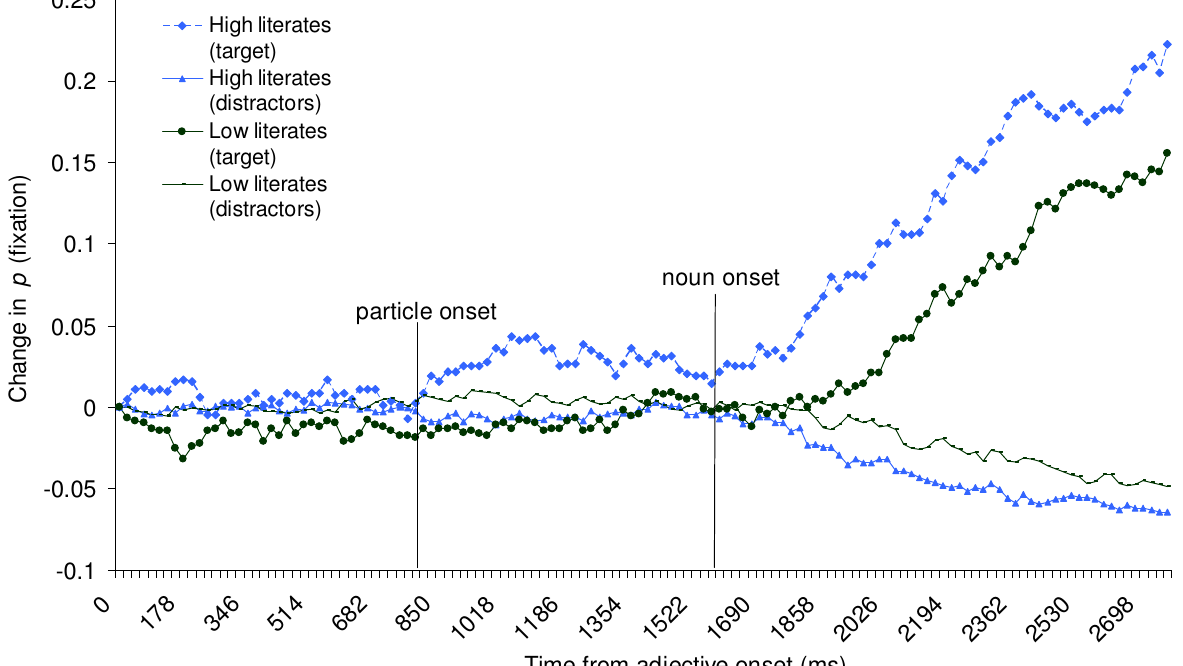
Figure 2 . Changes in fixation proportions on the target objects and (averaged) unrelated distractor objects for low liter- ates and high literates. Zero on the timeline is the acoustic onset of the adjective.